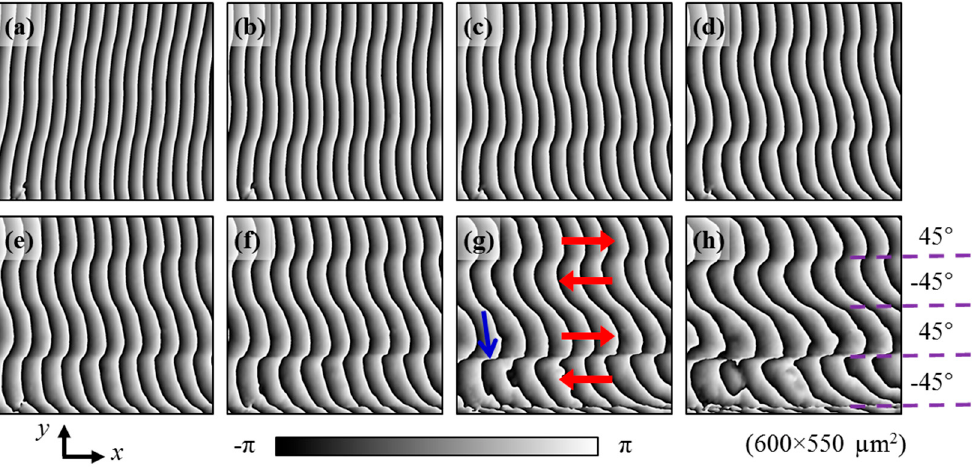
Figure 8. Visualization of the relative slip directions of different layers from revised Moiré phases in the x direction at ( a ) 127 MPa, ( b ) 199 MPa, ( c ) 238 MPa, ( d ) 258 MPa, ( e ) 272 MPa, ( f ) 292 MPa, ( g ) 313 MPa, and ( h ) 327 MPa.